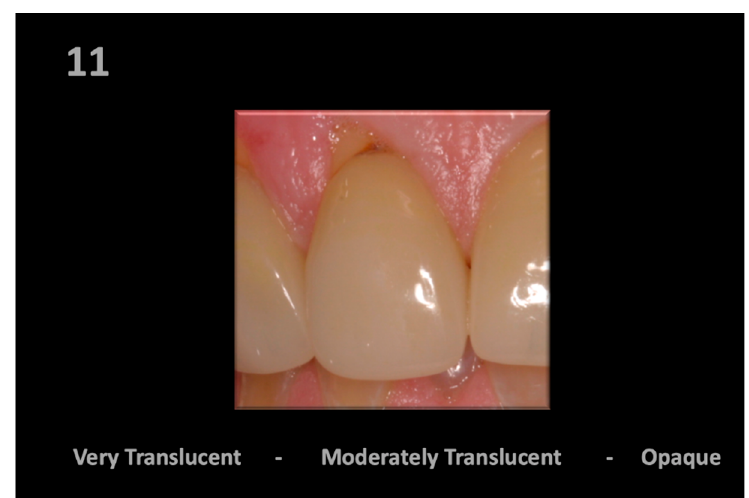
Figure 3. Example of monitor image the evaluator viewed with 3-point scale.